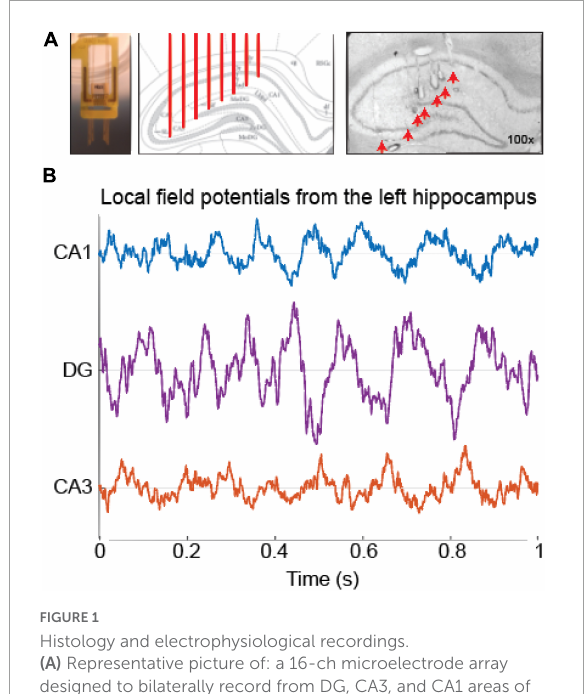
FIGURE1 Histology and electrophysiological recordings. (A) Representative picture of: a 16-ch microelectrode array designed to bilaterally record from DG, CA3, and CA1 areas of the dorsal hippocampus (left); the targeted anatomical areas (3,6 mm posterior to Bregma; Paxinos and Watson, 2013) and electrode positions in the hippocampus (red vertical lines, middle); a representative 50- µ m Nissl-stained coronal section of the left hemisphere of the dorsal hippocampus (right). Red arrows point to tissue lesions caused by electric currents individually applied at each electrode. (B) Representative examples of simultaneous recordings of hippocampal local field potentials. Traces on different colors show selected electrodes positioned in each hippocampal area: CA1 (blue), DG (purple), and CA3 (red). Note the phase reversal of the theta cycle between the DG and